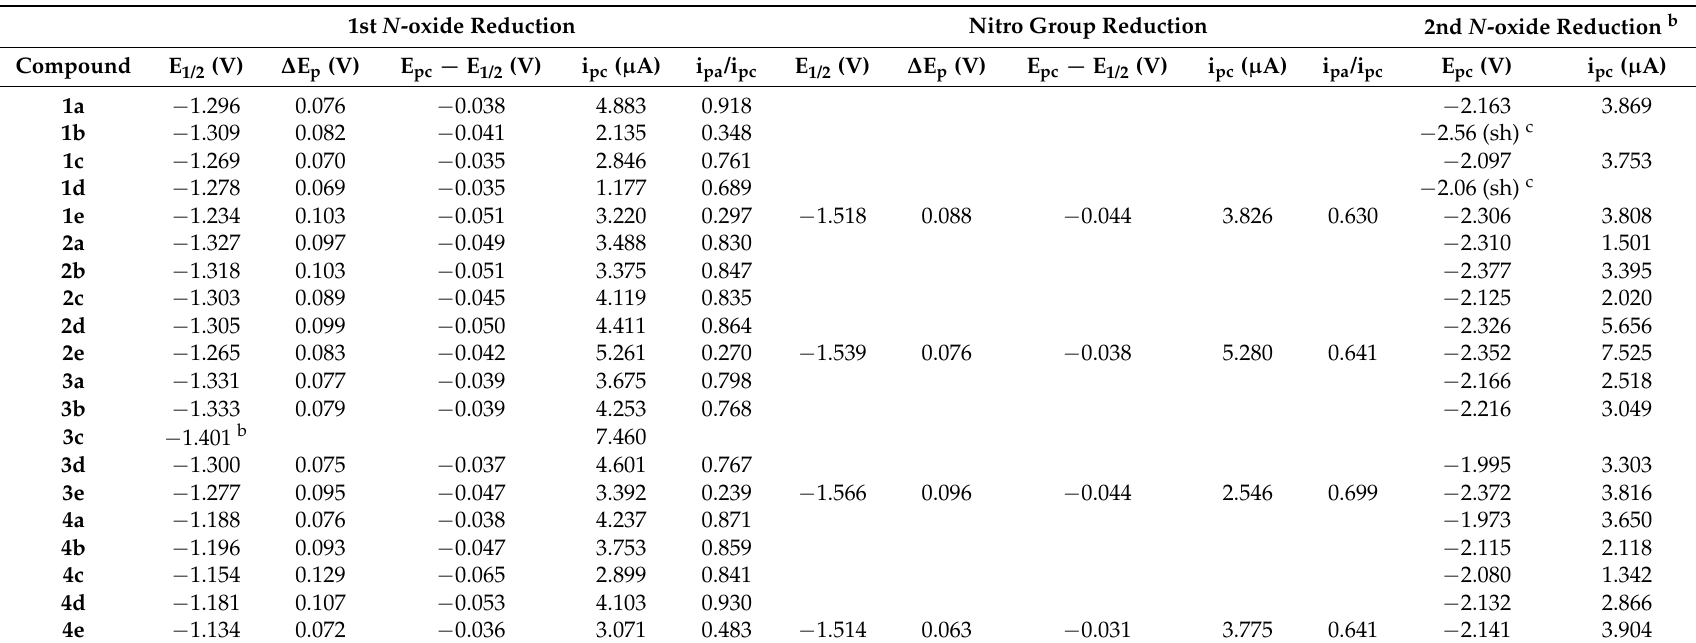
Table 2. Cyclic voltammetric data of the 3-aryl-quinoxaline-2-carbonitrile 1,4-di- N -oxide derivatives a